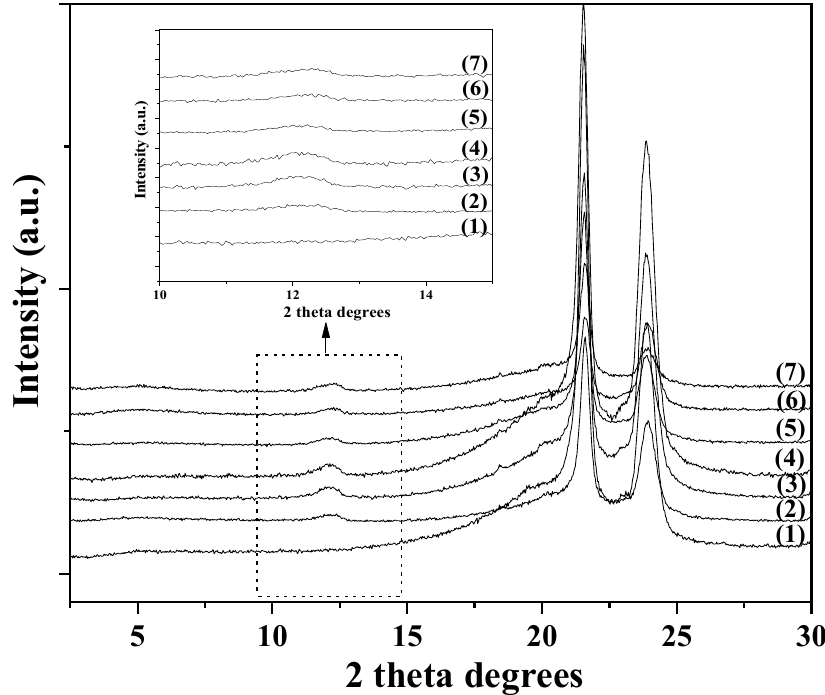
Figure 2. XRD plots in the range of 2 theta 2.5 ◦ to 30 ◦ of (1) pure LDPE, (2) LDPE/5HNT, (3) LDPE/10HNT, (4) LDPE/15HNT, (5) LDPE/5TO@HNT, (6) LDPE/10TO@HNT, and (7) LDPE/15TO@HNT. Inset figure with the same XRD plots in the range of 2 theta 10 ◦ to 15 ◦ . Pure LDPE film has two crystallization peaks at 2 theta 21.6 ◦ and 23.8 ◦ . Increasing HNT or TO@HNT %wt. content in LDPE/xHNT or LDPE/xTO@HNT films, the LDPE’s characteristic peaks decrease. Moreover, the characteristic peak of HNT basal space for all LDPE/xHNT and LDPE/xTO@HNT films is obtained at 12.1 ◦ . This implies that no opening of HNT’s basal space is achieved, and HNT or TO@HNT nanostructures are uniformly dispersed inside LDPE’s chains. Moreover, in the inset graph of Figure 2, the XRD plots exhibit a basal space peak at 12.1 ◦ for the HNTs, which is also observable for all LDPE/xHNT and LDPE/xTO@HNT films for higher analysis. For LDPE/xHNT films, it is observed that, as the %wt. HNT content increases, the peak slightly increases. This implies that, by increasing the %wt. HNT content, the aggregation of HNT increases and the dispersion of HNT decreases. In addition, the same peak of LDPE/xTO@HNT films is lower than that of LDPE/xHNT films. This implies that the dispersion of the modified TO@HNT in LDPE matrix is higher compared to the dispersion of the pure HNT in LDPE. 3.3. FTIR Spectroscopy of LDPE/xHNT and LDPE/xTO@HNT Films The FTIR plots of pure LDPE (line (1)) of all LDPE/xHNT (see lines (4), (5), (6)) and all LDPE/xTO@HNT (see lines (7), (8), (9)) films are depicted in Figure 3. Moreover, the FTIR plots of pure HNT (line (2)) and TO@HNT hybrid nanostructure (line (3)) are